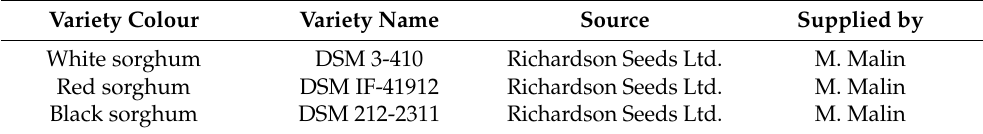
Table 1. List of sorghum